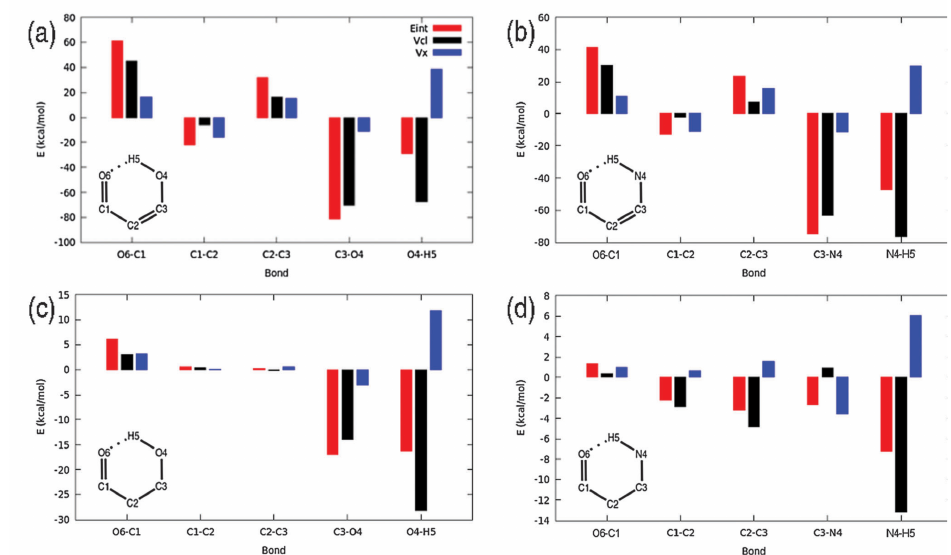
Figure 3. Interacting quantum atoms (IQA) allows for the individual changes in IQA interaction components accompanying the formation of the different hydrogen bonds. Figure from reference [98] shows systems with insaturations and intramolecular HBs ( a , b ), along with their non-conjugated counterparts ( c , d ). Figure reproduced by permission of the PCCP Owner